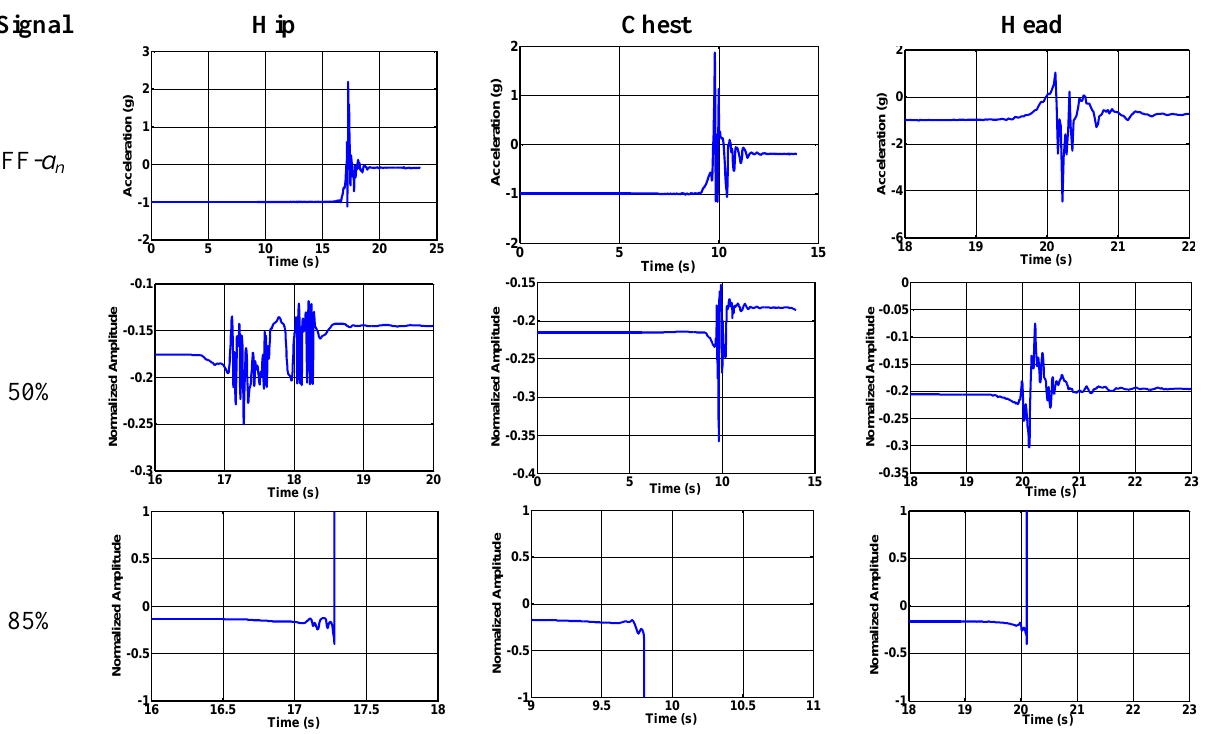
Figure 14. Simulation of the MEMS switch under the effect of 50% of fall signal (representing the ADL) and 85% of fall signal (representing the start of the fall